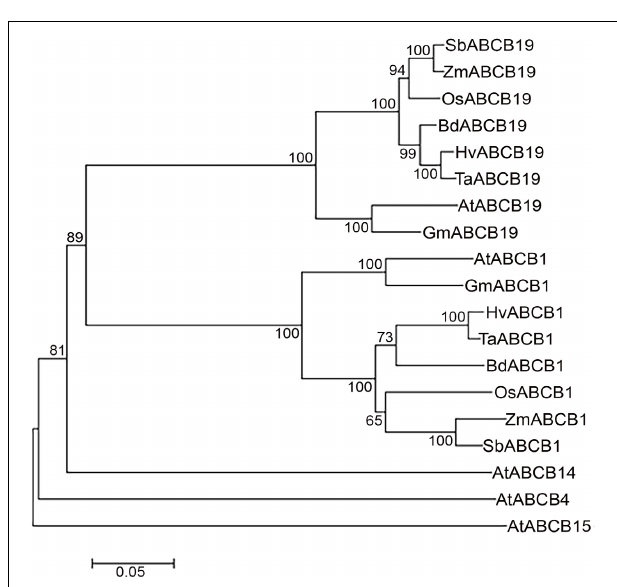
respectively compared to 70.6 and 92.4% in dicots. The sequence identity between TMD1 and TMD2 was 25% and between NBD1 and NBD2 was 56%.